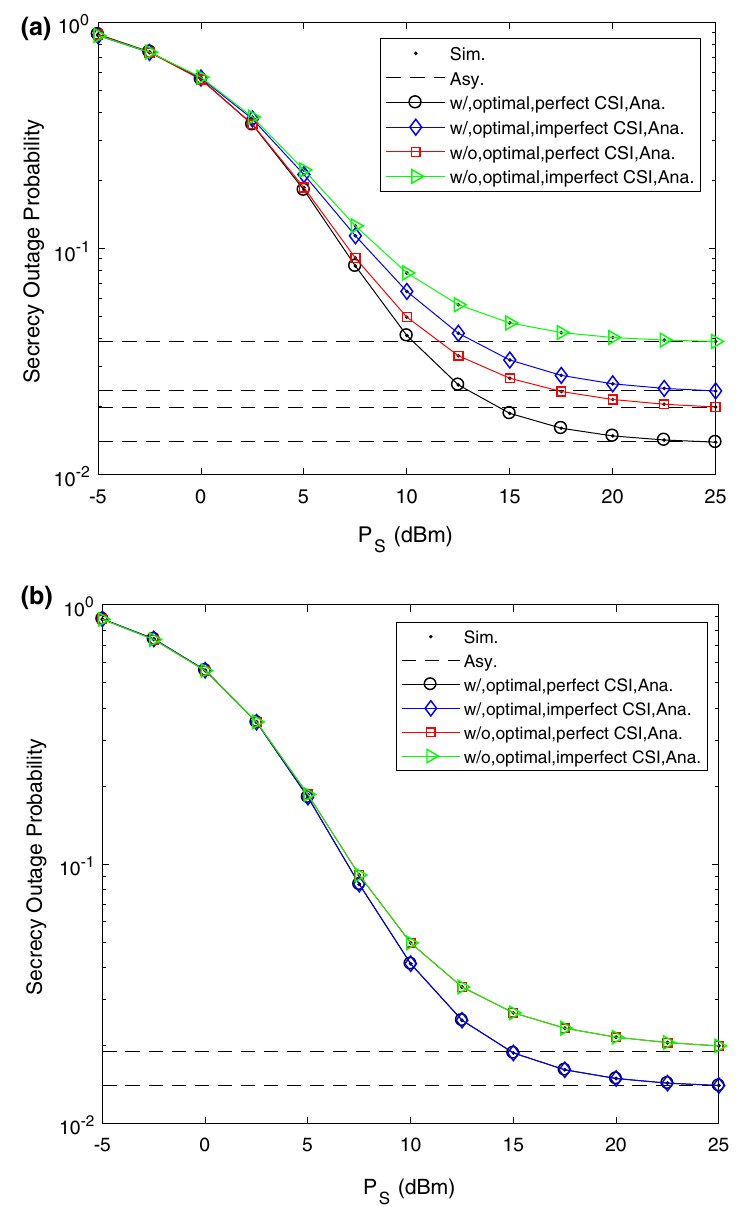
Fig. 4 The theoretical results and simulation results of SOP versus transmit power. ( a ) The channel estimation error is 0.1; ( b ) The channel estimation is zero, i.e., perfect CSI. The SOP of the proposed schemes VS